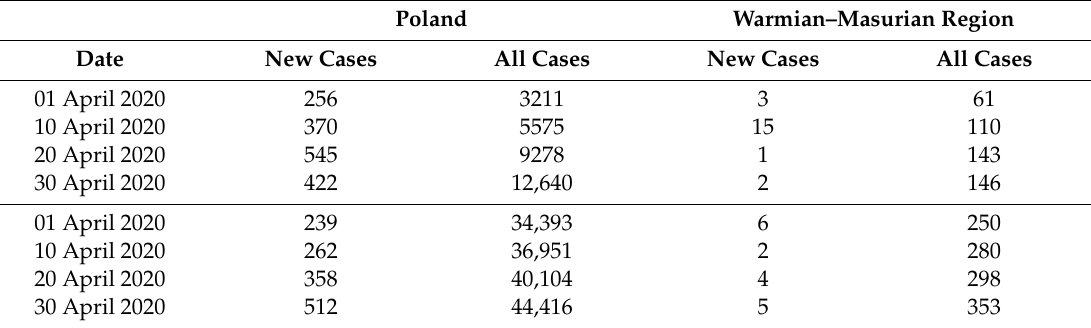
Table 2. The course of the COVID-19 epidemic in April and July 2020 in Poland and in the Warmia and Mazury region.